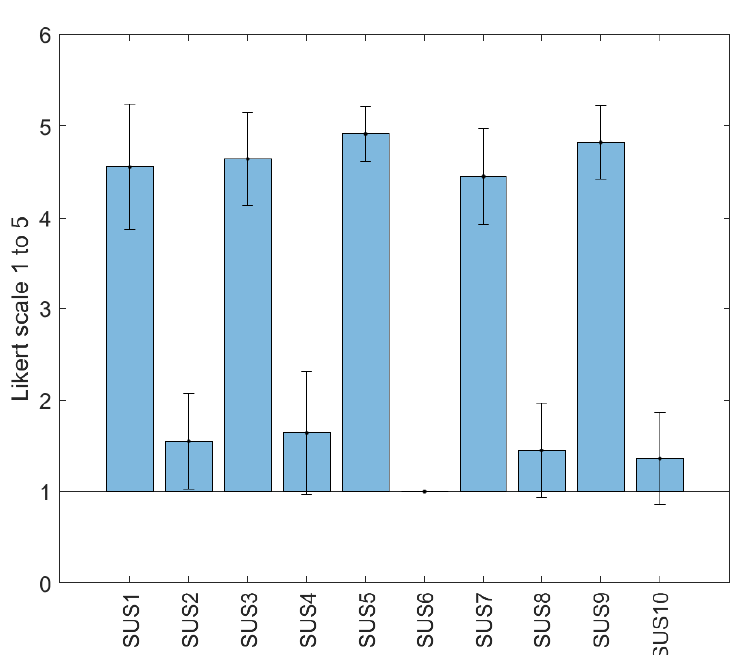
Figure 12. Results of the SUS questionnaire (mean and standard